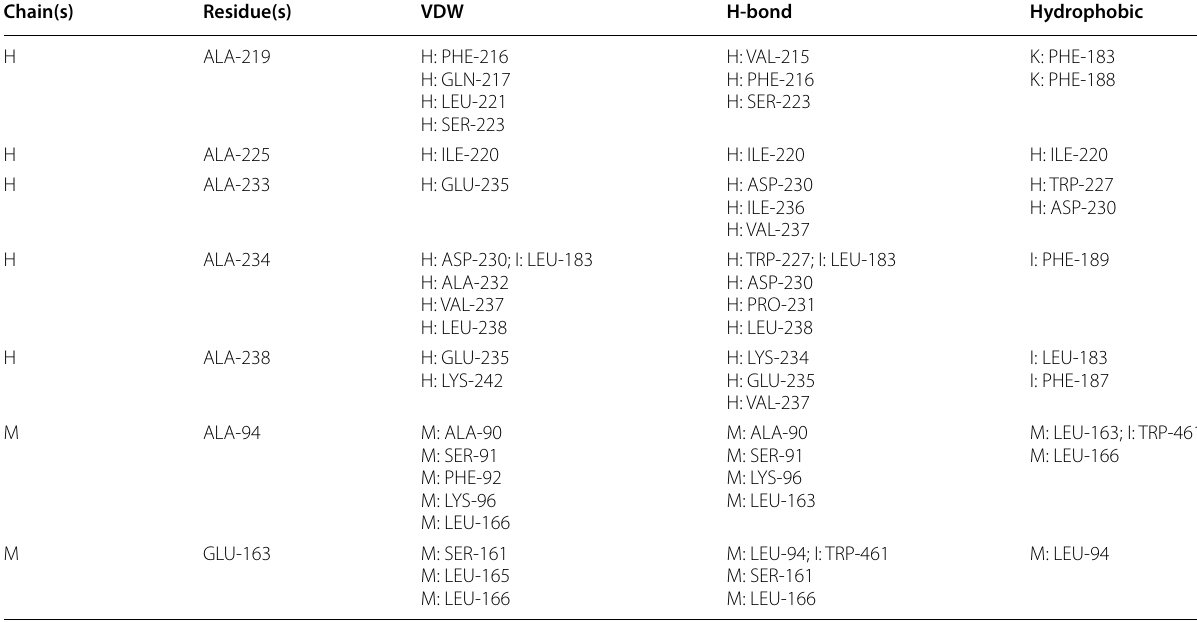
The first and second columns show the mutated chains and residues of interest, while the remaining columns represent the observed interaction types (van der Waals, hydrogen bond and hydrophobic interactions, respectively). Specific chains and residues that interact with the mutant residues are presented in the corresponding columns for each interaction